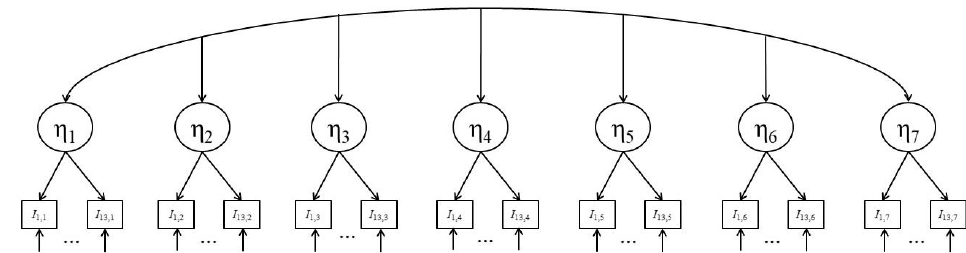
Figure 4. Cognitive ability-confirmatory factor analysis (CFA). η 1 – η 7 represent the latent ability variables measured by the figural matrices test items in every test session. I 1,1 represents the first